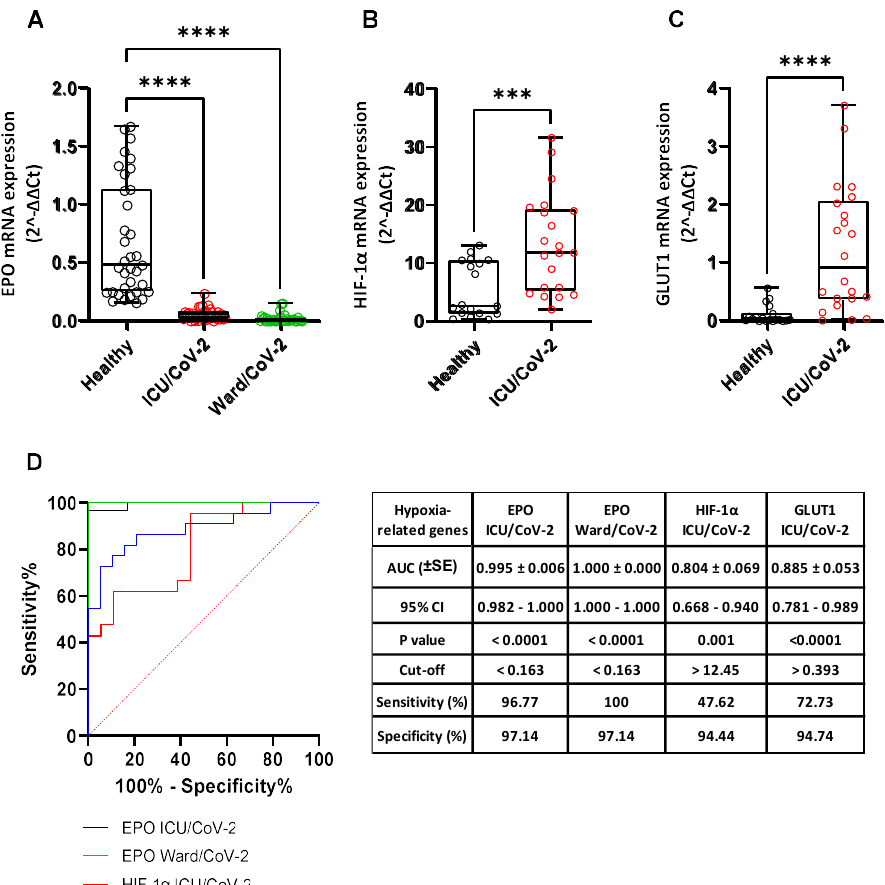
Figure 12. Box plot diagram of the mRNA expression of EPO ( A ), HIF-1α ( B ) and GLUT1 ( C ) in whole blood samples of healthy subjects and hospitalized SARS-CoV-2 patients (ICU/CoV-2, Ward/CoV-2). p -values were determined by the non-parametric Kruskal–Wallis test, and multiple comparisons were conducted with Dunn’s post hoc analysis. *** p < 0.001, **** p < 0.0001 vs. Healthy. ( D ) ROC curve analysis for the aforementioned-genes expression. AUC, 95% CI, p -values, and cut-off points with their specificity and sensitivity were reported. The red dotted line denotes perfect chance (positive likelihood ratio = sensitivity/(1-specificity) = 1).